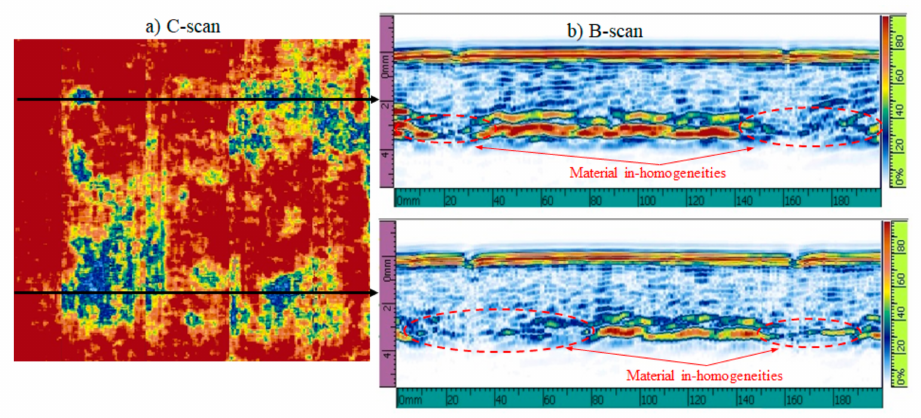
Figure 6. C-scan ( a ) and B-scan ( b ) images taken on the impacted side of the PA6B specimen (see Figure 4 for impact energies location).